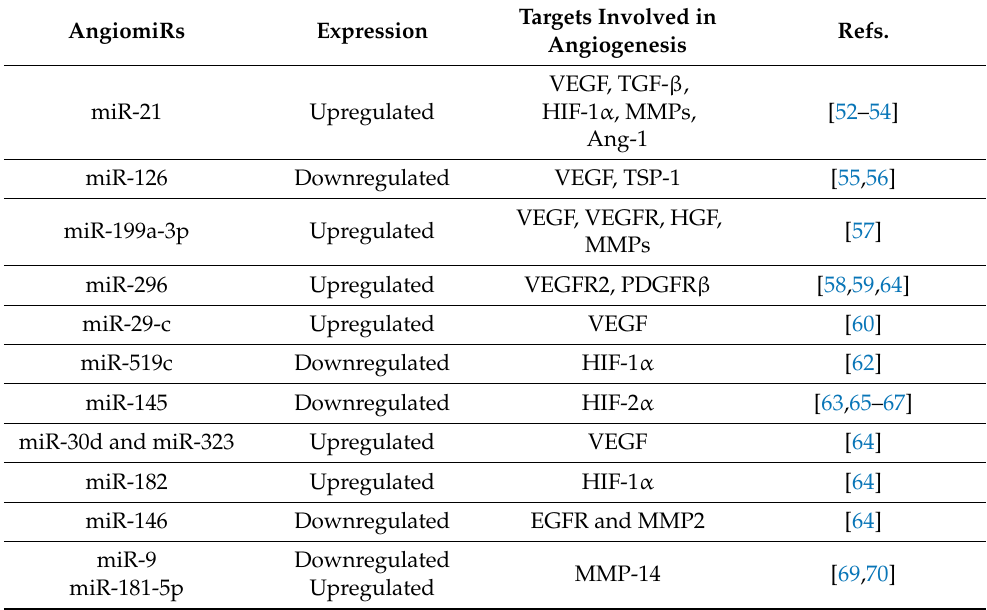
Table 2. Main microRNAs implicated in angiogenesis and their expression and targets. AngiomiRs Expression